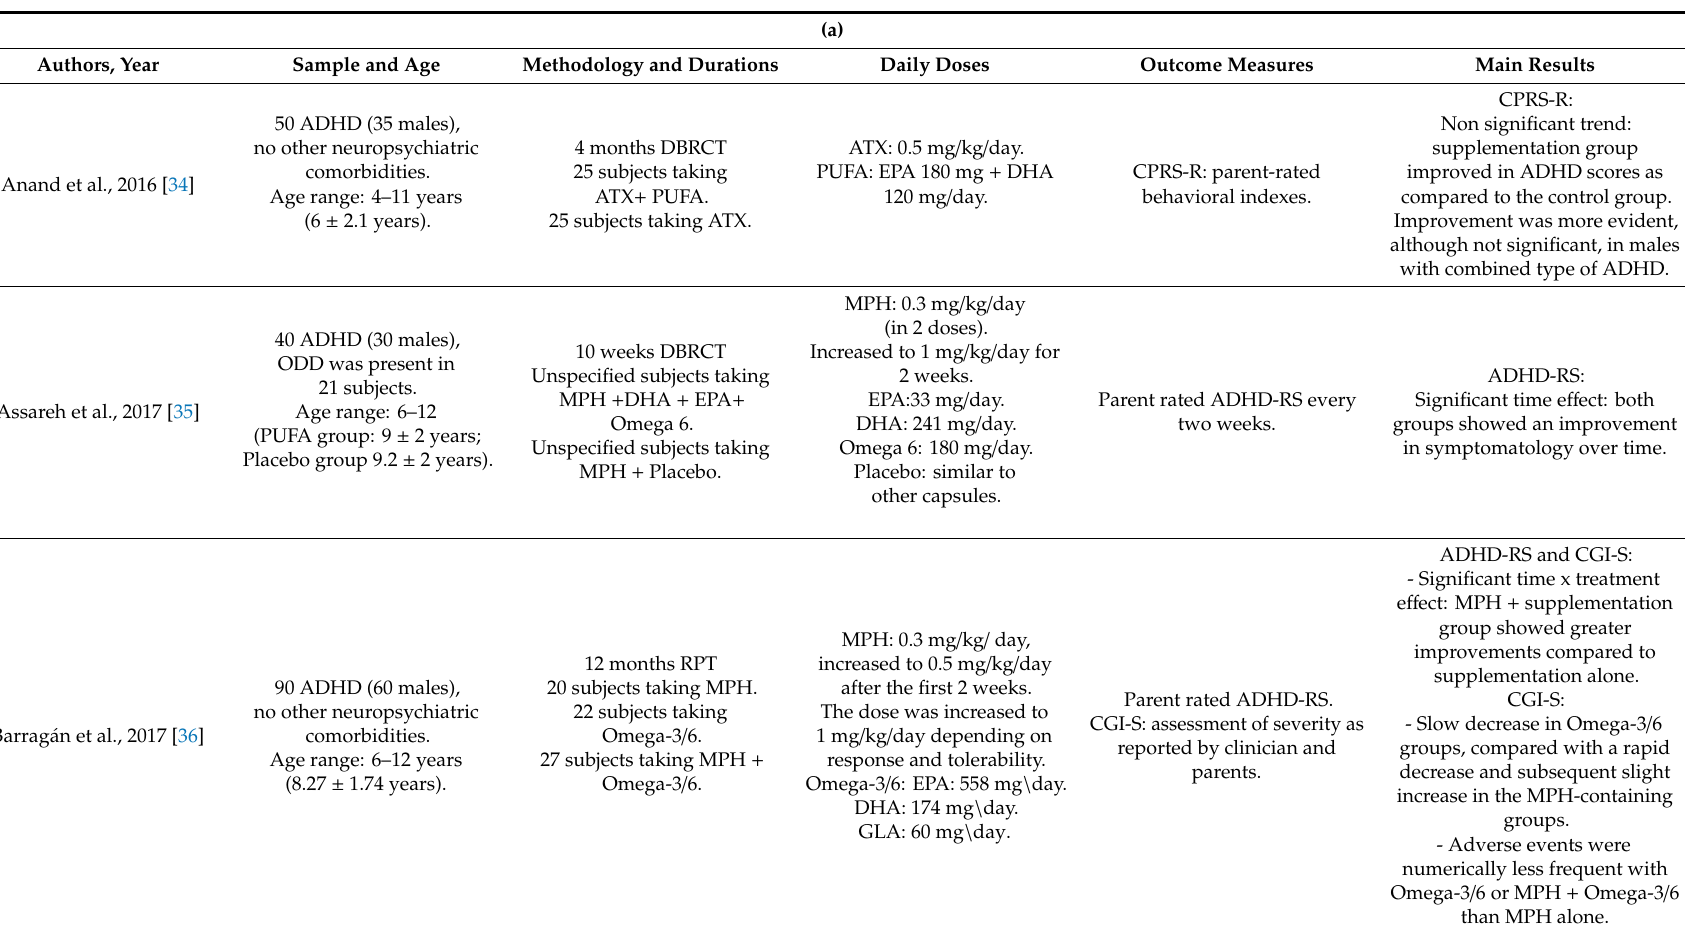
Table 1. ( a ) Studies comprising supplementation with polyunsaturated fatty acids (PUFAs). ( b ) Studies comprising supplementation with peptides and amino acids derivatives. ( c ) Studies comprising supplementation with a single micronutrient. ( d ) Study comprising supplementation with micronutrients mix. ( e ) Studies comprising supplementation with plant or herbal extracts. ( f ) Study comprising supplementation with